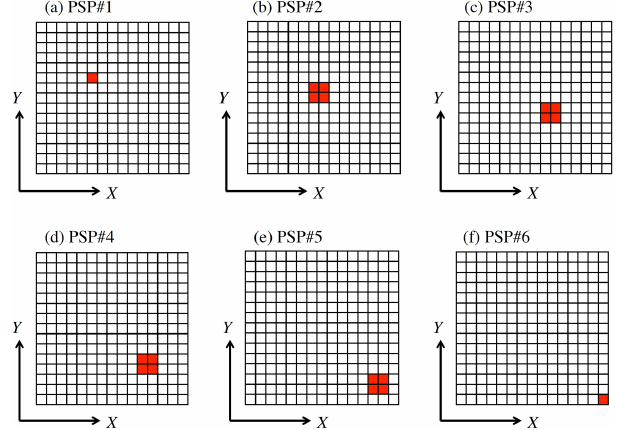
Figure 11. Muon scattering inside the telescope. The event was nor- malized to the total number of